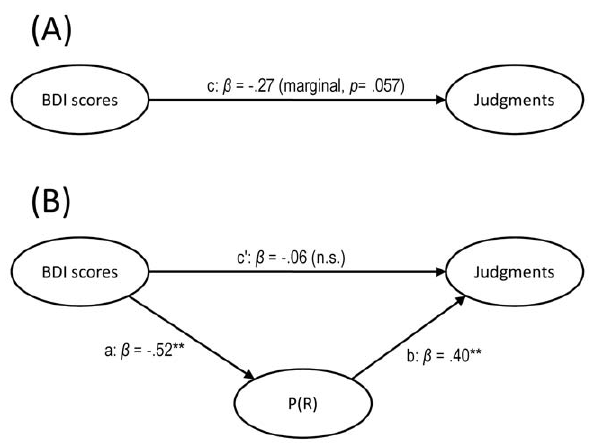
Figure 1. Mediational model tested in Study 1. The letters a, b, c, and c’ depict the paths between the three variables, which are weighted by the standardized regression coefficients. One or two asterisks indicate a significant coefficient (p , .05 or p , .01, respectively), while n.s. means that the coefficient failed to reach the significance level (p . .05). Panel (A): Path c corresponds to the predictive link between BDI scores and the judgments (i.e., the total effect in the model). The negative coefficient indicates that we replicated the depressive realism effect. Panel (B): The total effect (Path c above) can be decomposed into two components, the direct effect and the indirect